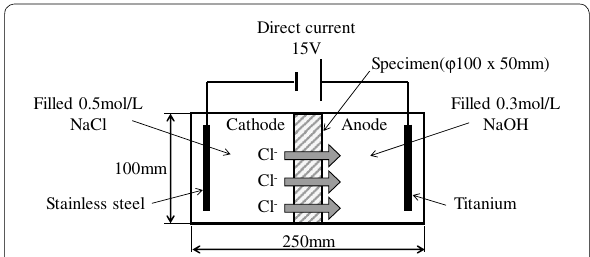
Fig. 1 Test method for ingress of chloride ions in concrete by